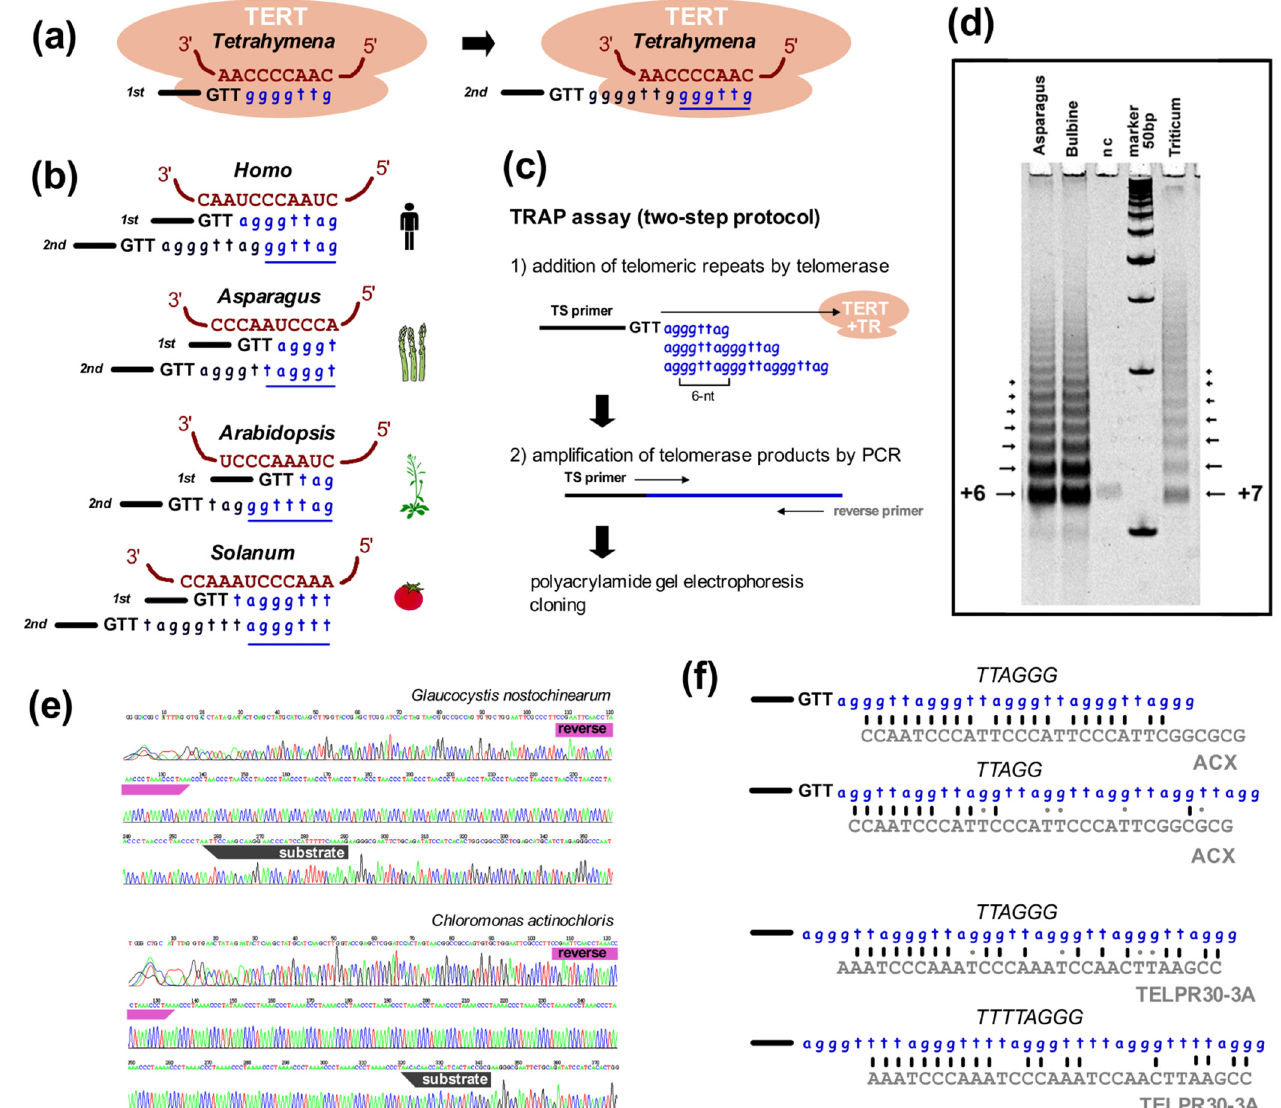
Figure 3. TRAP assay helps to verify telomeric repeat synthesized by telomerase . ( a ) Telomerase adds telomere repeats at the 3 ′ telomeric overhang (here shown as GTT-3 ′ , black). Firstly, substrate ssDNA anneals to the template region of telomerase RNA (brown) and nucleotides are added (blue) up to the end of the template region. The substrate is then reannealed and a new repeat is synthesized such that one repeat (underlined) is added per round. ( b ) Representative template regions of the TR subunit. The template regions of telomerases synthesizing the same type of telomere repeat may be different, e.g., human and Asparagus officinalis (Asparagales), or Arabidopsis (Brassicales) and tomato (Solanales). ( c ) Classical TRAP is a PCR-based assay for the investigation of telomerase activity through elongation of the telomerase substrate primer, e.g., the widely used TS primer (5 ′ -AATCCGTCGAGCAGAGTT-3 ′ , [224,228]). The sequence added by telomerase corresponds to the template region. Elongation products are amplified by PCR with the substrate primer and a C-rich telomeric reverse primer. ( d ) A ladder of products is visualized on a polyacrylamide gel. TRAP products from Asparagales plants with a human-type telomeric repeat produced a ladder with 6-bp periodicity, while 7-bp periodicity was detected in wheat used as a control (nc—negative control) [139]. ( e ) Sequencing of cloned TRAP products revealed synthesis of the TTAGGG-type telomeric repeat in Glaucocystis nostochinearum (Glaucophyta, [142]) and the TTTTAGGG-type of telomeric repeat in Chloromonas actinochloris (Chlorophyta, [30]). Both TRAP reactions were performed using various substrate primers and a reverse primer (TELPR30-3A) corresponding to the TTTAGGG-type telomeric repeat, primer sites are highlighted. ( f ) Examples of the limited sequence similarity of reverse primers (grey) targeting telomerase elongated products.